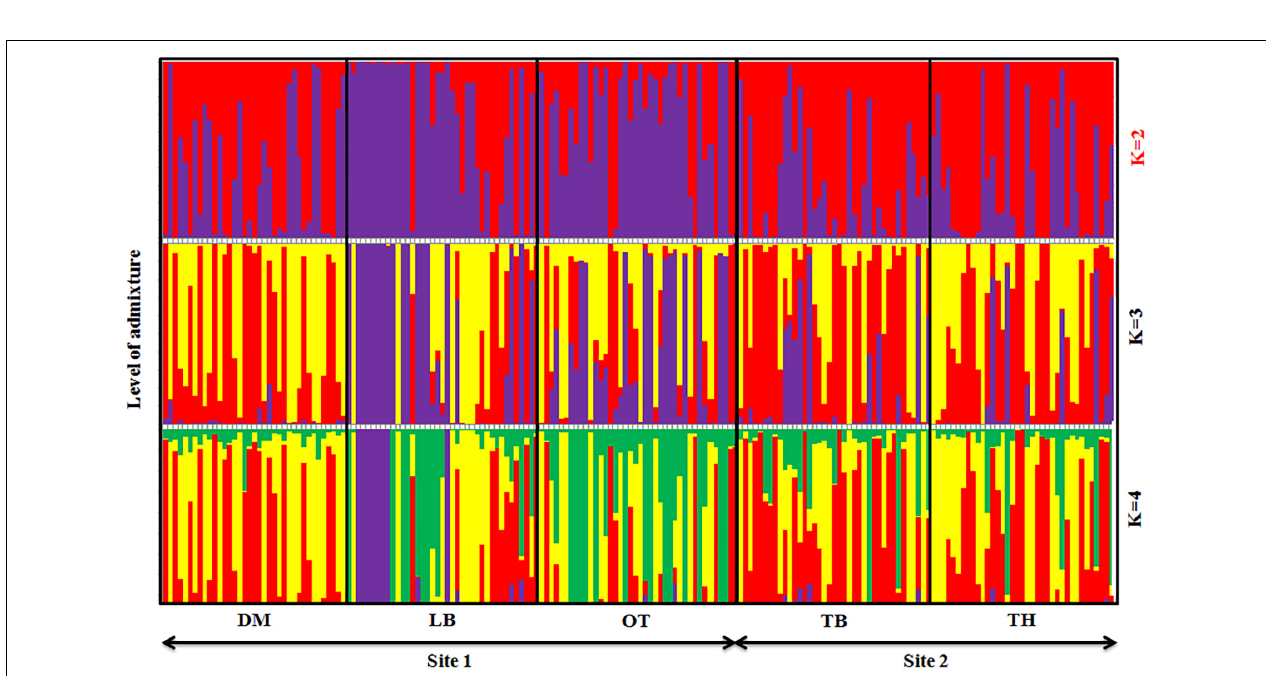
FIGURE 5 | Summary bar plot of estimates of Q (the estimated membership coefficient for each individual in each cluster). Each individual is represented by a single vertical line broken into K colored segments with lengths proportional to K inferred clusters (best K = 2). Chicken phenotypes: NN, naked neck; LL, long legged; CC, crested or crown; FF, frizzle feathered; GR, Giriraj, CL, commercial layer; CR, crossbreds; VC, non-descript chicken.